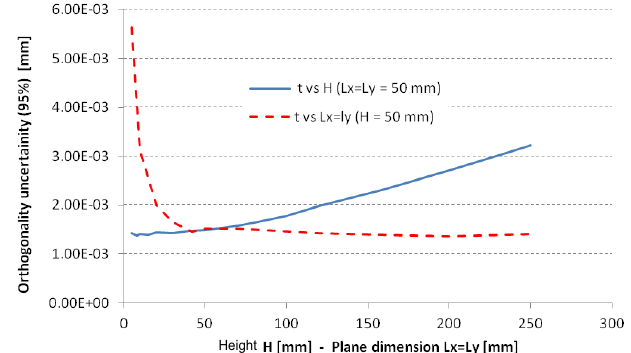
Fig. 10. Orthogonality uncertainty in different geometrical configurations ( R = 8 mm, L x = L y displayed on chart leg- end).